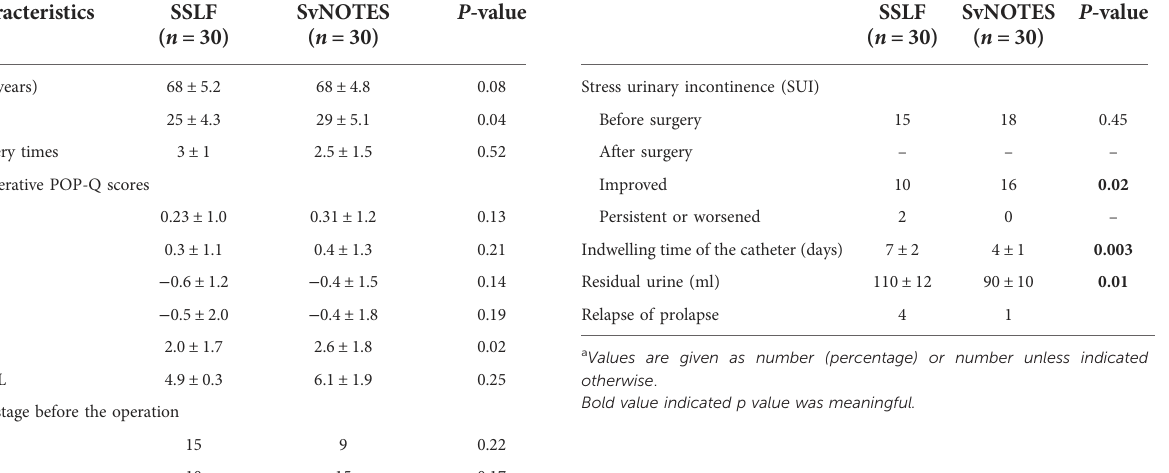
TABLE 4 Postoperative objective observation indexes. a